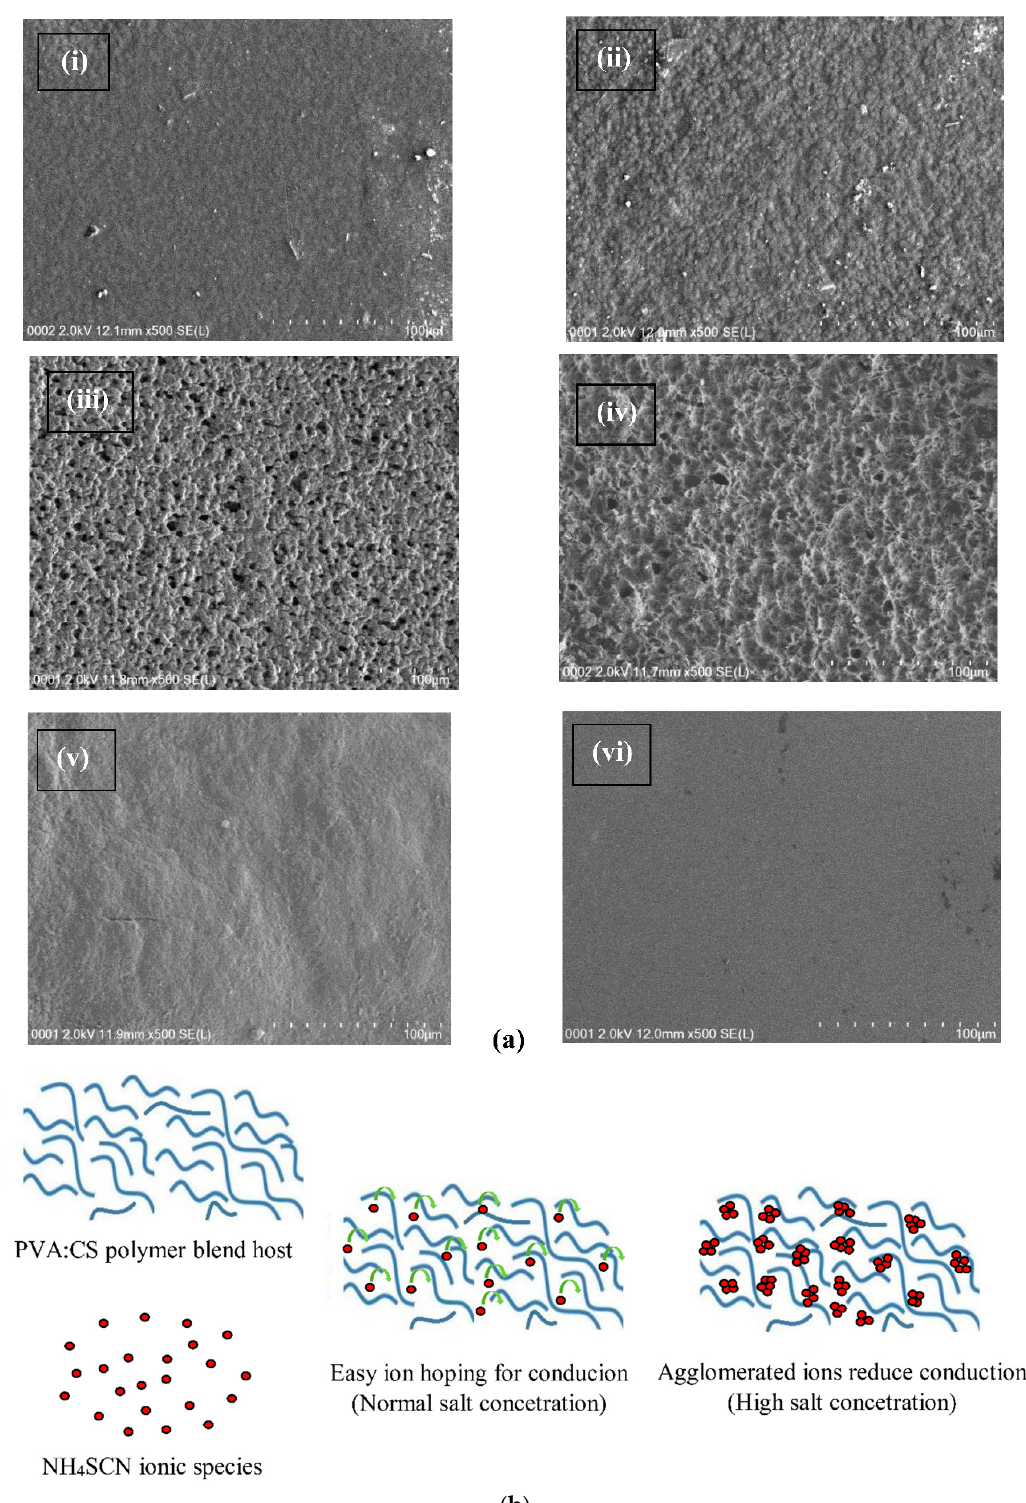
Figure 2. ( a ) FESEM micrographs of (i) PCSH1, (ii) PCSH2, (iii) PCSH3, (iv) PCSH4, (v) PCSH5, and (vi) pure PVA/CS blend electrolytes. ( b ) Schematic illustration of ionic transfer in normal NH 4 SCN salt concentration and blockage of pathways caused by ion agglomeration in high NH 4 SCN salt concentration.